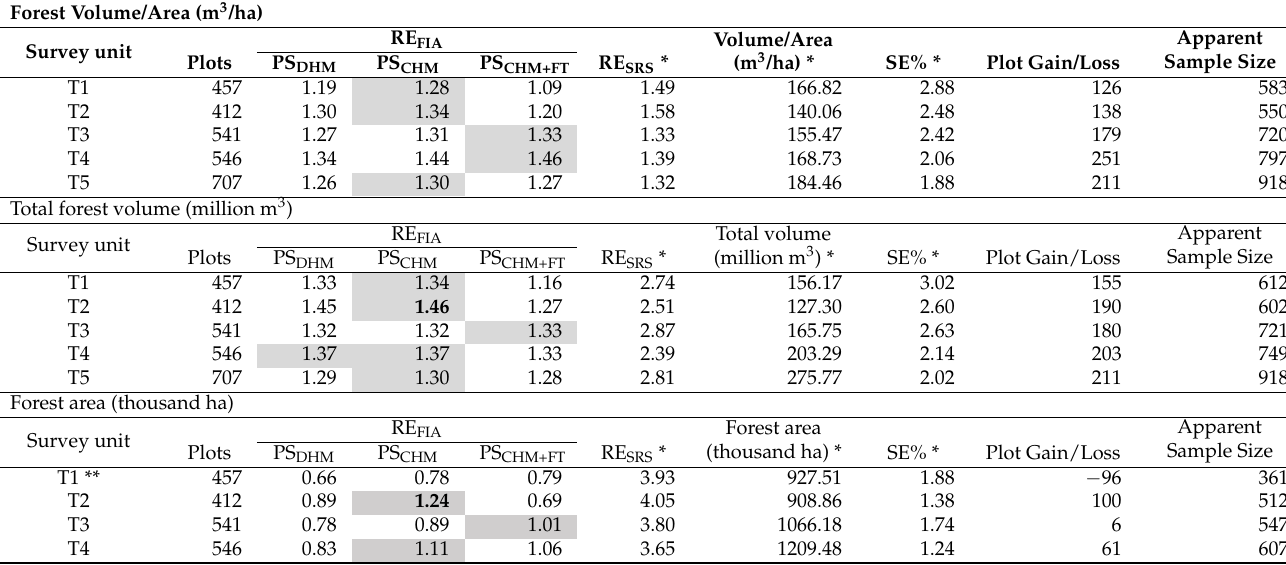
Table 4. Post-stratified estimation